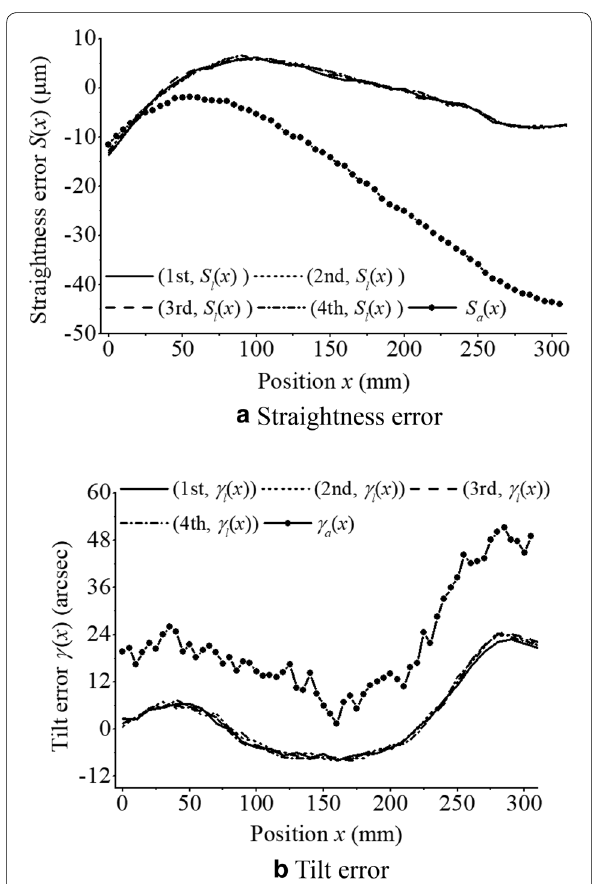
Figure 9 Experimental results obtained by the new four-sensor method and the laser interferometer